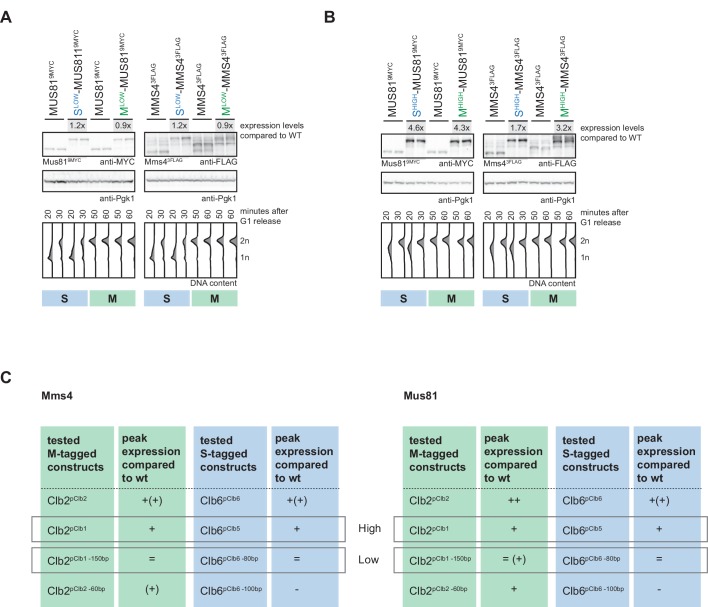
Analysis of ‘low’ and ‘high’ S- and M-tagged Mus81-Mms4 peak expression levels.(A/B) Sets of Slow-Mus81-Mms4 (Clb6pClb6 -80bp)/Mlow-Mus81-Mms4 (Clb2pClb1 -150bp) (A) and Shigh-Mus81-Mms4 (Clb6pClb5)/Mhigh-Mus81-Mms4 (Clb2pClb1) (B) display similar peak expression levels. Western blot analysis of peak expression levels at individual time points after G1 release. Expression levels were quantified using Image-J and signals at the individual time points were divided by the corresponding Pgk1 sample to normalize to overall protein levels. Normalized protein levels of Slow-/Mlow-Mus81-Mms4 and Shigh-/Mhigh-Mus81-Mms4 were compared to wt expression at the corresponding time point (fold difference) and the two analysed time points (20 and 30 min time points for S phase and 50 and 60 min time points for M phase) for each construct were averaged to result in a mean fold difference that is indicated above the western blots. Bottom: DNA content measurement by flow cytometry. (C) Summary of peak expression levels of various cell cycle-tagged Mus81/Mms4 constructs. Depicted are relations of peak expression values in comparison to WT, which lead to selection of ‘high’ and ‘low’ expressing constructs.